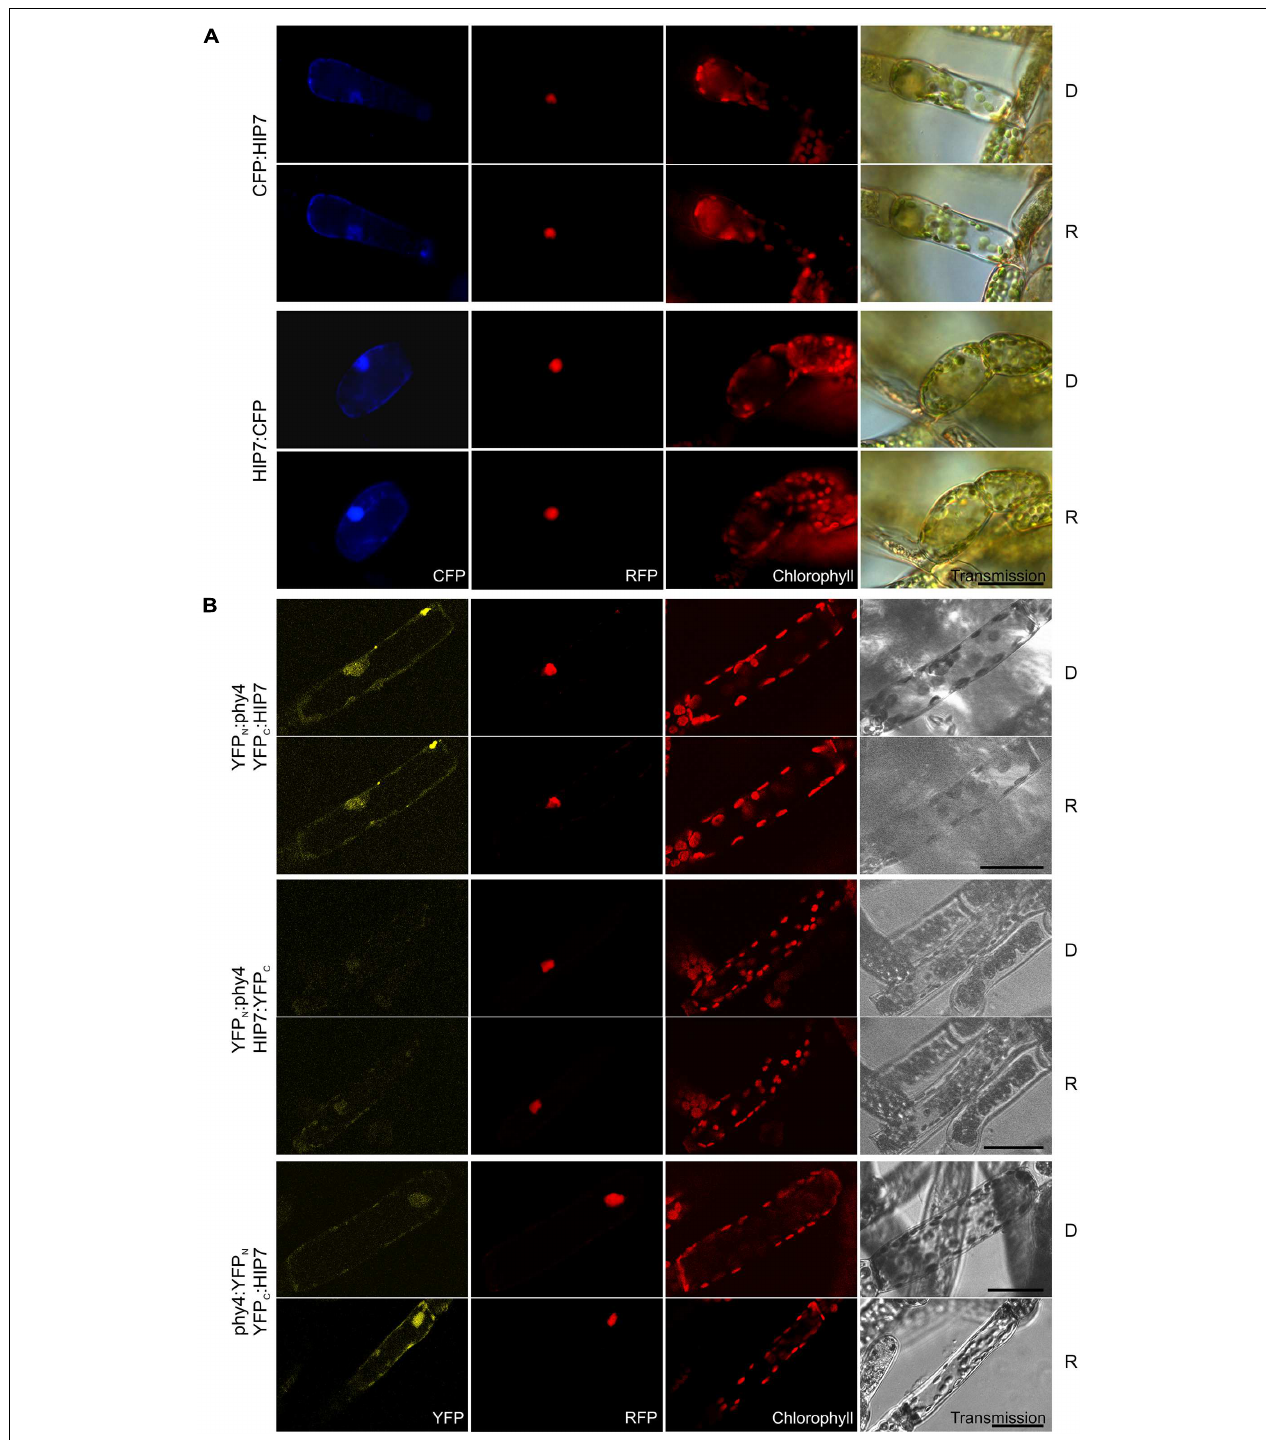
FIGURE 6 | HIP7 (Pp3c17_9390V1.1) intracellular localization (A) and split-YFP-studies of HIP7–phy4 interaction (B) each without (D) and with R pre-treatment (R) using fluorescence- and confocal microscopy, respectively. Overall figure structure is analogous to Figure 1 . (A) Intracellular localization of CFP:HIP7- (rows 1 and 2) and HIP7:CFP-fusions (rows 3 and 4) was observed, showing nuclear and cytoplasmic signal patterns (column 1, CFP). CFP:HIP7 in addition showed cytosolic foci in ∼ 40% of the cells observed. (B) Three of four possible split-YFP configurations were analyzed: YFP N :phy4–YFP C :HIP7 (rows 1 and 2), YFP N :phy4–HIP7:YFP C (rows 3 and 4) and phy4:YFP N –YFP C :HIP7 (rows 5 and 6). YFP N :phy4–YFP C :HIP7, and phy4:YFP N –YFP C :HIP7 yielded significant split-YFP-signals mostly in nucleus and cytoplasm (column 1, YFP). In the latter case significant signals were only seen after R-pre-treatment (D and R conditions here being shown from independent experiments). Scale bars 30 µ